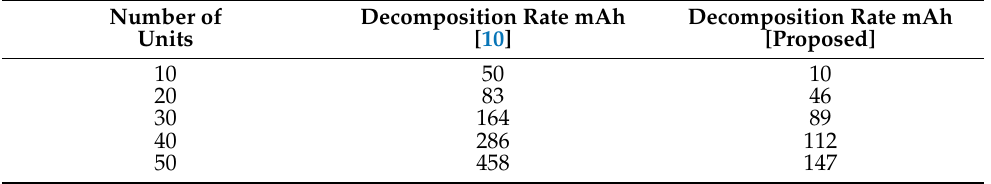
Table 3. Unit decomposition.